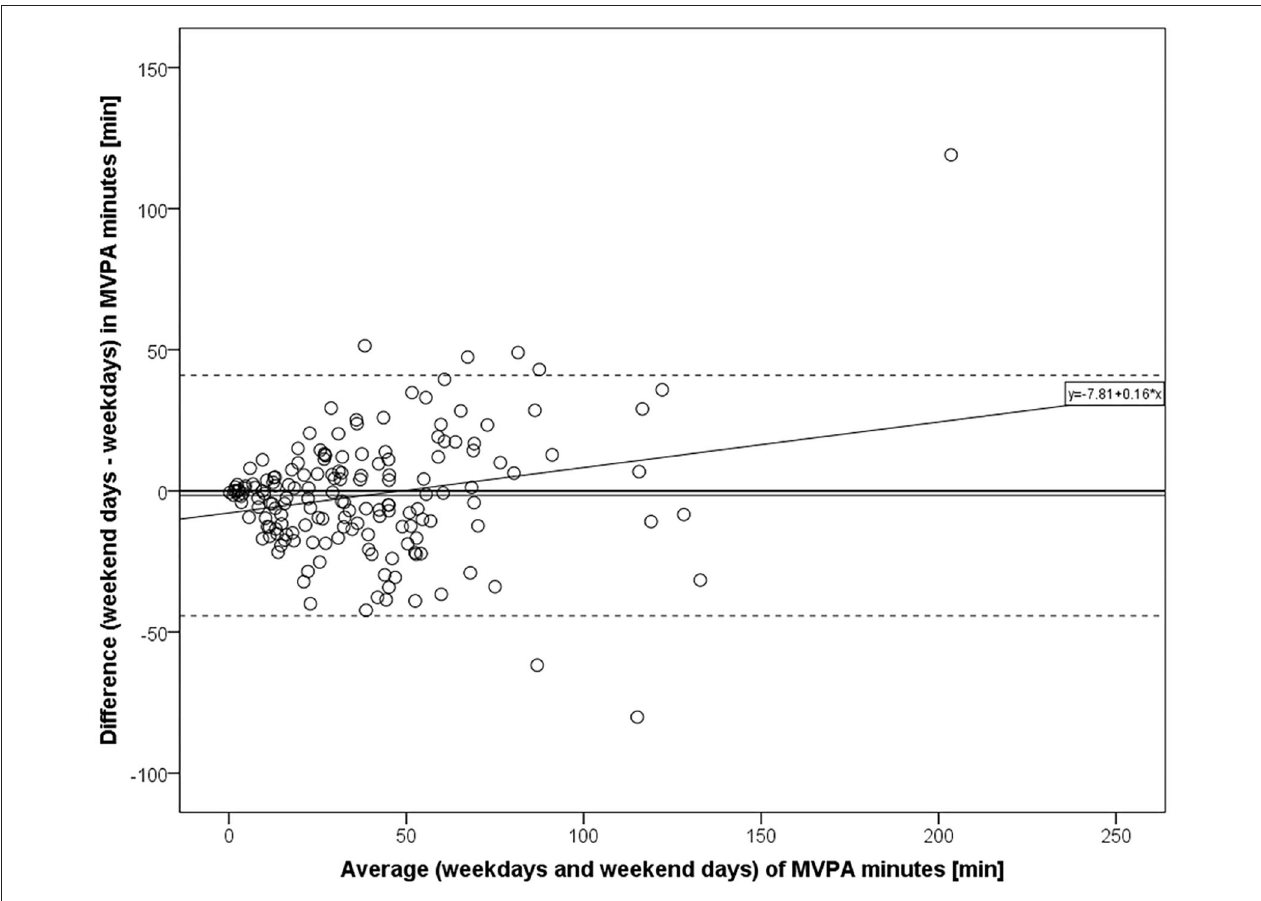
FIGURE 2 | Bland-Altman plot for MVPA minutes on weekend days vs. weekdays ( n = 167). Mean difference with 95% confidence intervals and regression line ( R 2 = 0.052, p = 0.003 for β